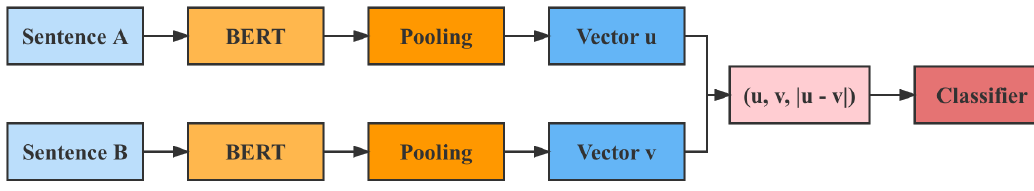
Figure 7. The structure of the BERT sentence